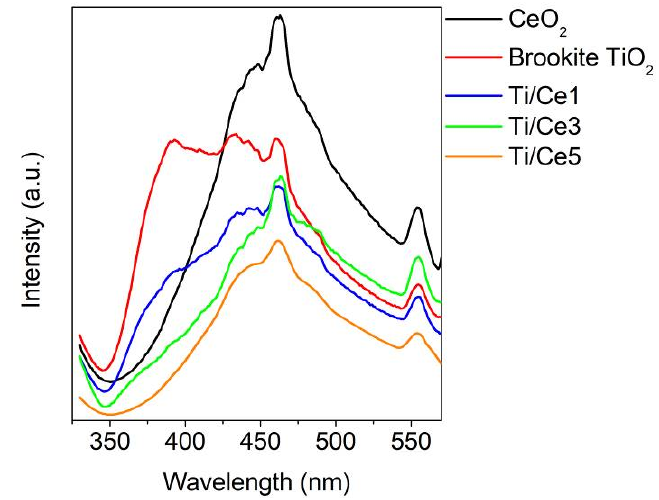
Figure 5. Photoluminescence spectra of the analyzed samples ( λ excitation = 300 nm).